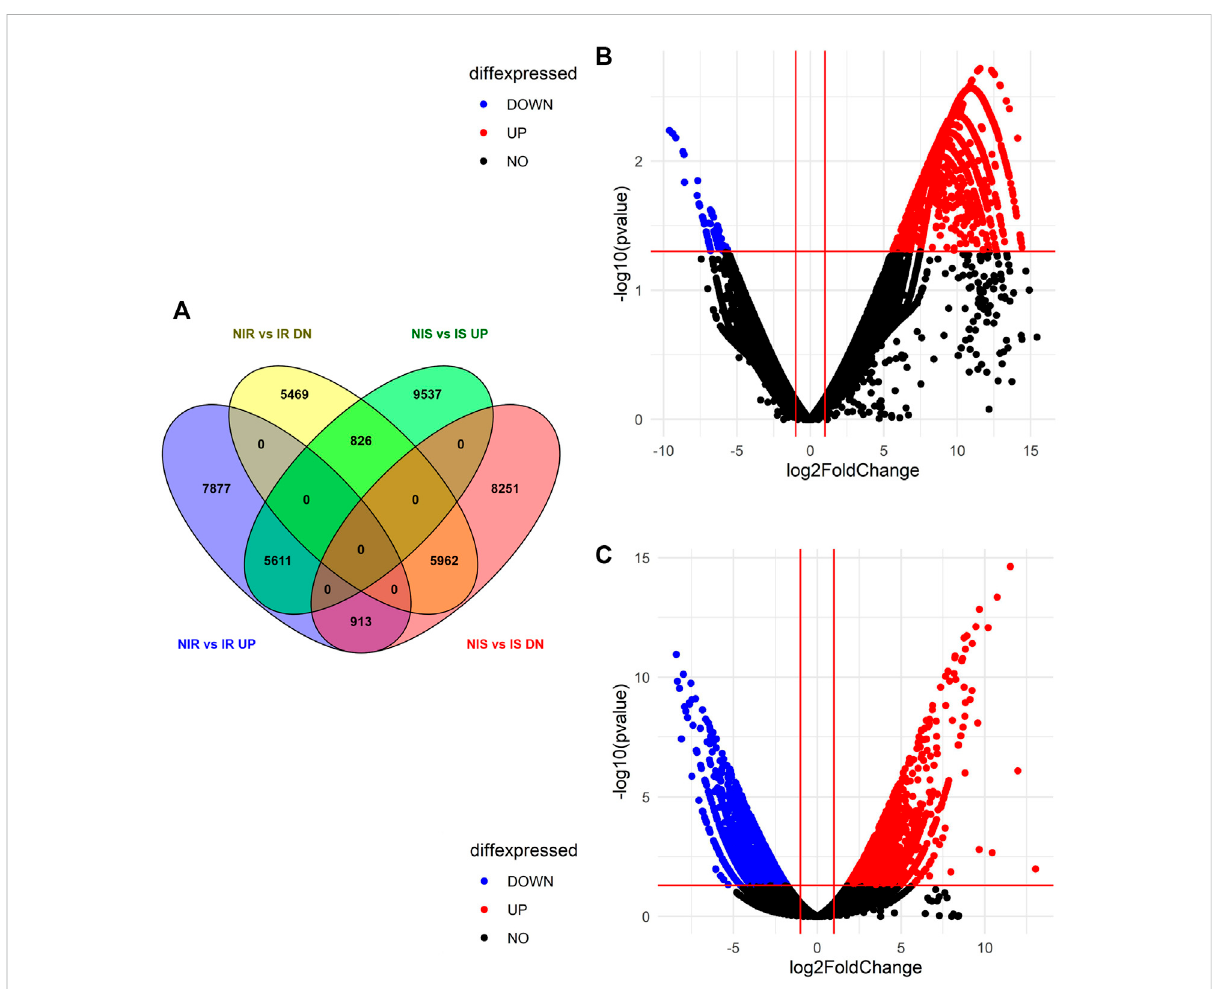
FIGURE 2 Differential expressed genes identi fi ed in both the susceptible and resistant cultivars. (A) Venny 2.1.0 software analysis of differential expression of genes in NIR vs IR and NIS vs IS. (B) Volcano plot representing DEG data in NIS vs IS. (C) Volcano plot representing DEG data in NIR vs